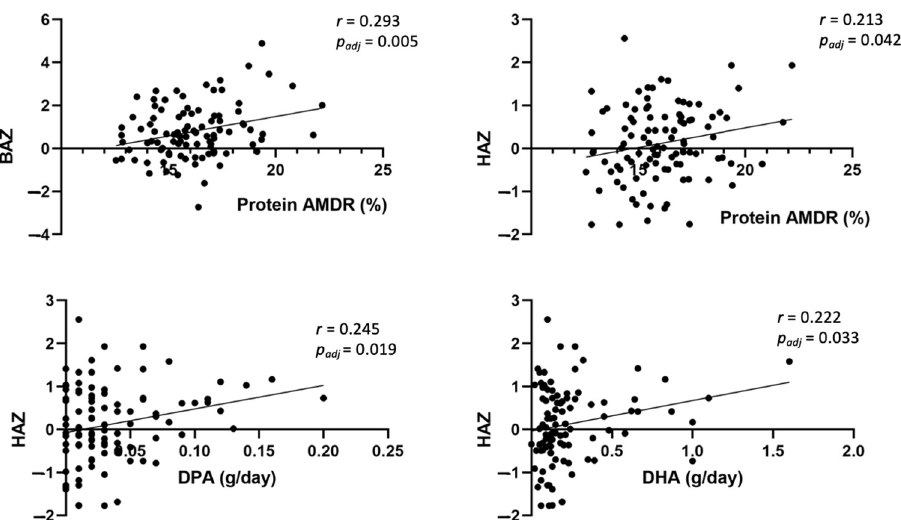
Figure 4. Partial correlation to evaluate potential associations between anthropometric data and dietary intake in children at 6 years, adjusted by study group, maternal age, parents’ educational level, and socioeconomic status. AMDR: acceptable macronutrient distribution ranges; BAZ: body mass index for age z -score; DHA: docohexaenoic acid; DPA: docosapentaenoic acid; HAZ: height for age z -score.